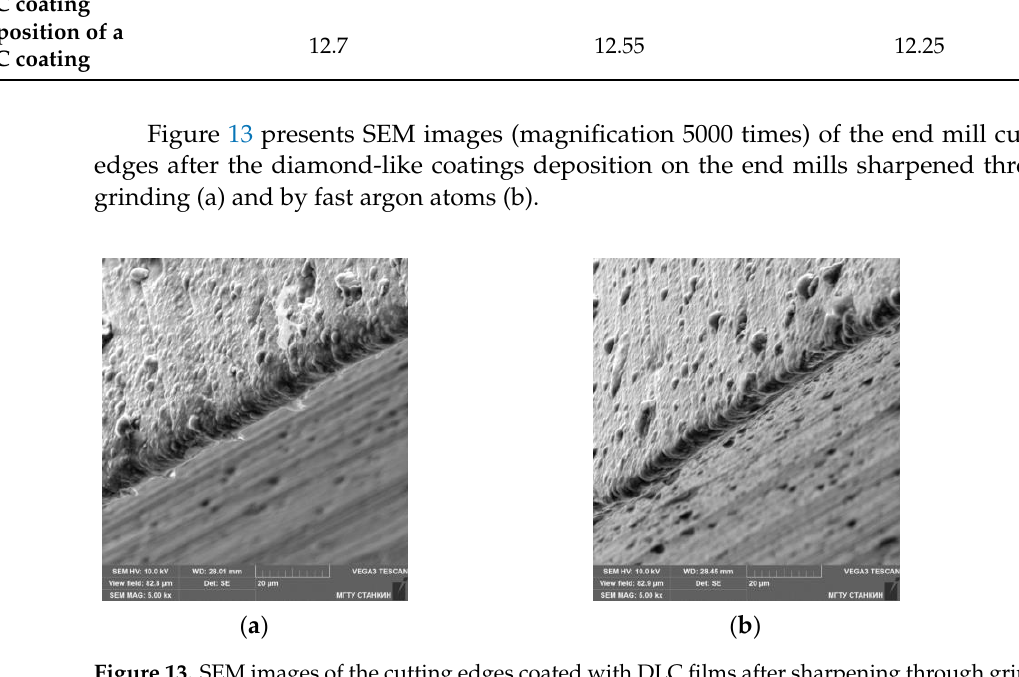
Figure 13. SEM images of the cutting edges coated with DLC films after sharpening through grinding ( a ) and by fast argon atoms ( b